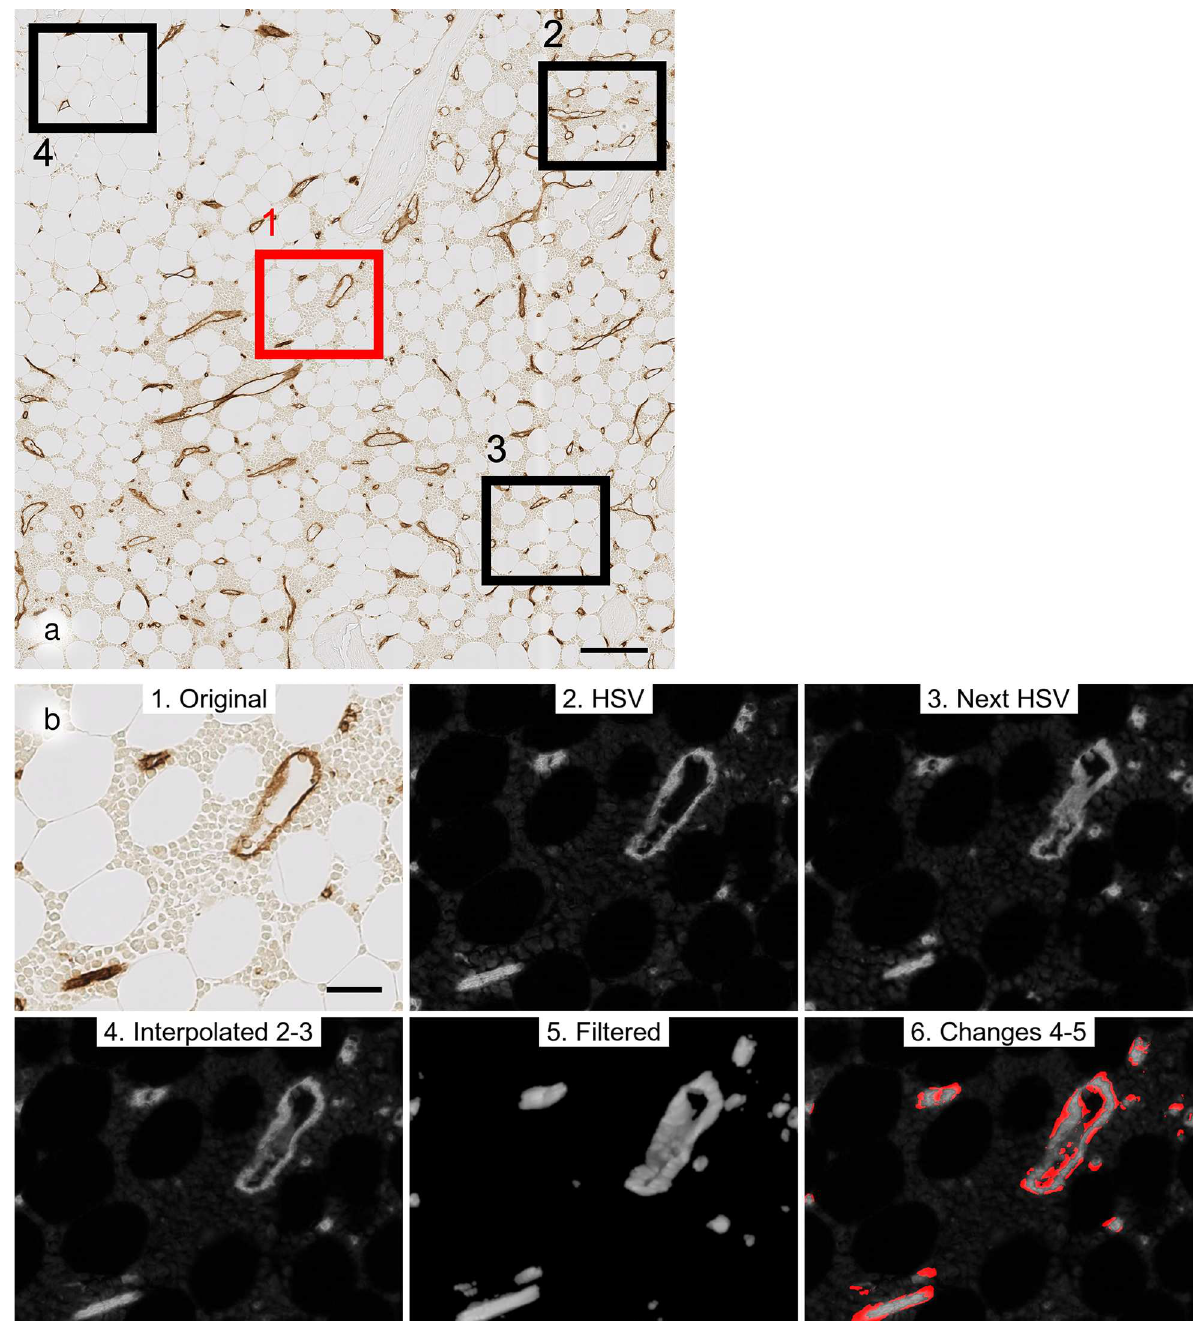
Fig 6. Semi-automatic QC. (a) R 1 containing4 small regions for semi-automatic QC of volume data processing. The regionvisualisedin (b) is colouredred. Scale bar = 100 μ m. (b) Sequenceof QC visualisedfrom left to right in upper and lower part of panel: originalscan (1), HSV conversionof scan of current serial section (2), HSV conversionof next serial section (3), interpolationbetweenboth serial sections: in this case the fourth of seven images is shown (4), final result of all filtering operationsof interpolatedimages (5), areas different betweeninterpolatedimages and result of filtering colouredred (6). Scale bar = 25 μ m.